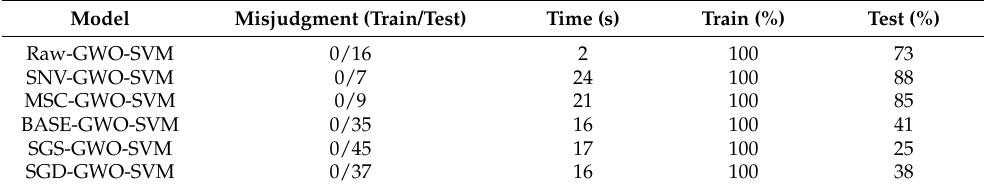
Table 5. The GWO-SVM classification models established by the original Ranman spectra and the Ranman spectra after after five different kinds of